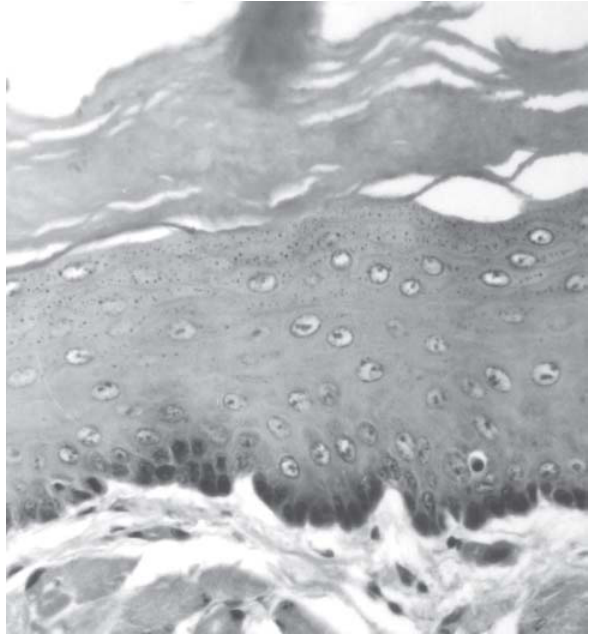
FIGURE 1- Microscopic section of a specimen in Group I demonstrating hyperorthokeratinization, some mitoses, preservation of epithelial stratification and normal hypercromatism of the basal layer, besides integrity of the basal membrane